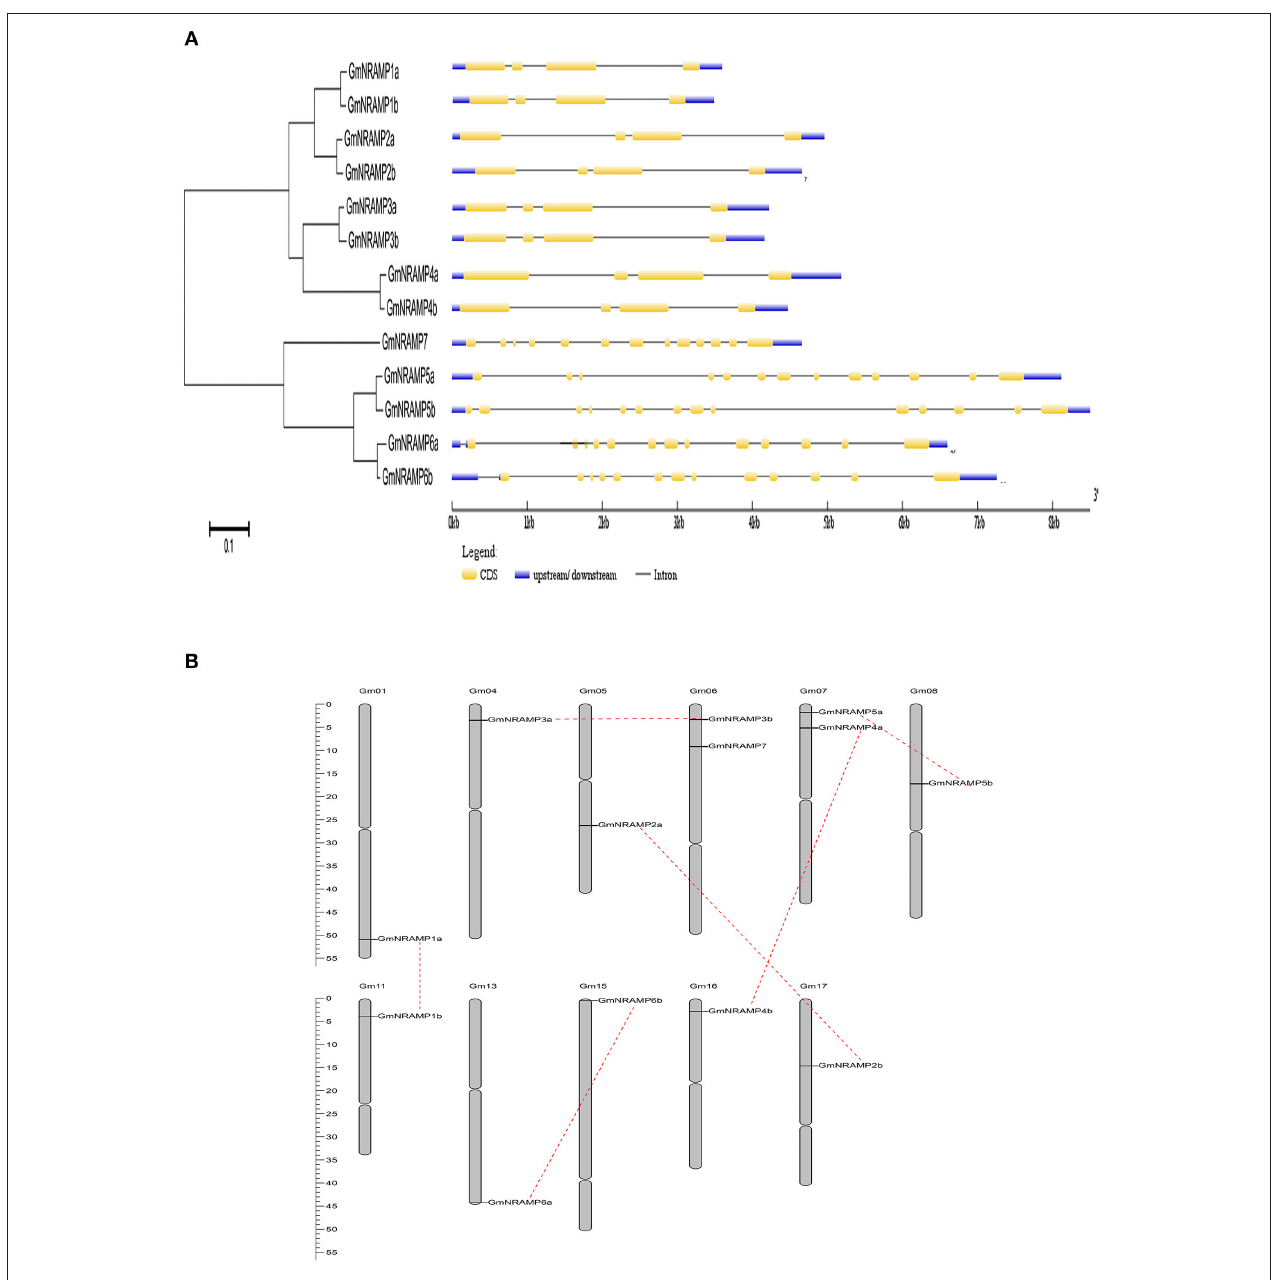
FIGURE 1 | Phylogenetic relationships, gene structures, and chromosomal positions of soybean NRAMP family genes. (A) Phylogenetic relationships of soybean NRAMP family genes. The phylogenetic tree was constructed based on sequence alignment of soybean NRAMPs using the neighbor-joining method with bootstrapping analysis in MEGA 6.0 (1,000 replicates). Gene structures were drawn by Gene Structure Display Server 2.0 with genomic sequences and CDS sequences of each NRAMP gene. Introns and exons are represented by black lines and yellow boxes, respectively. Blue boxes represent UTRs. (B) Positions of NRAMP family genes on soybean